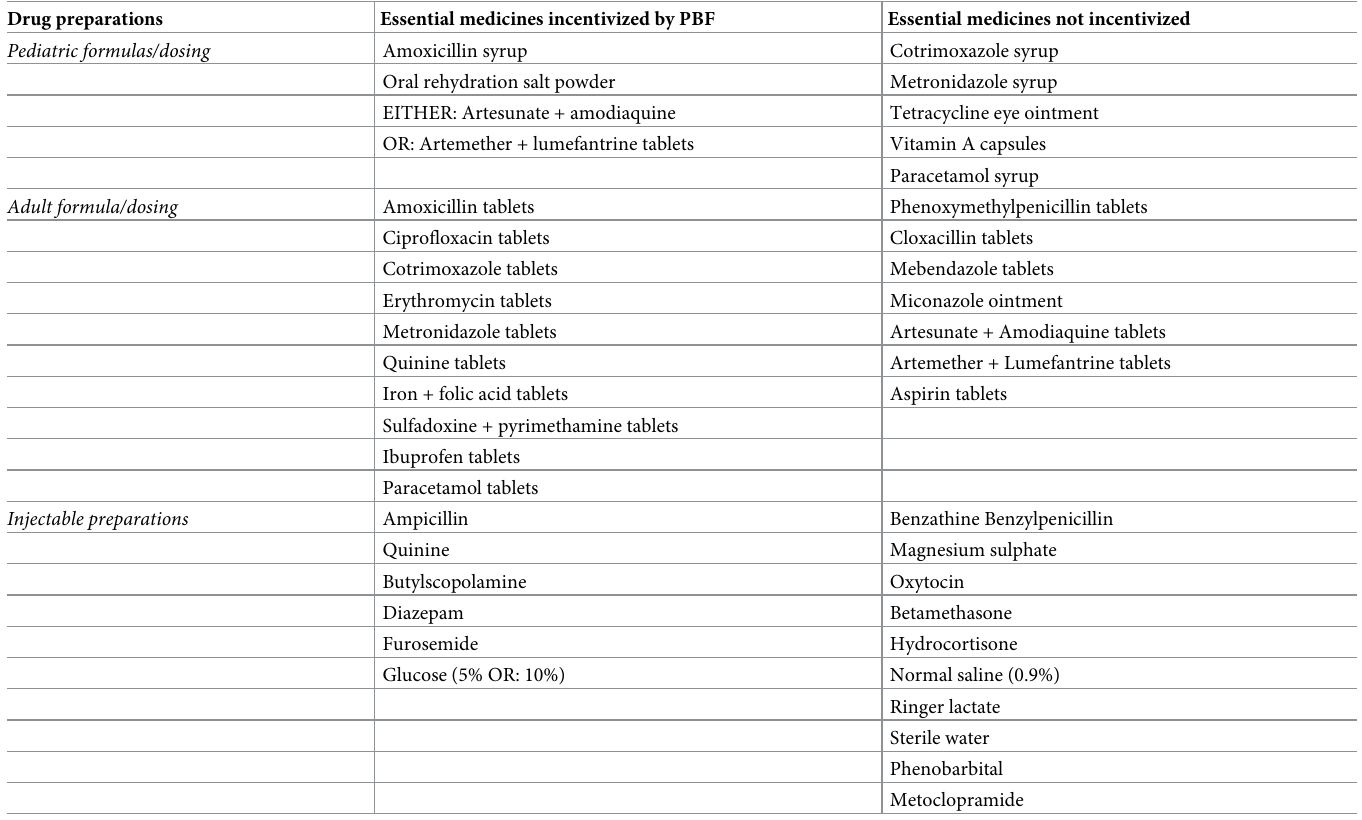
Table 1. Essential medicines included in the